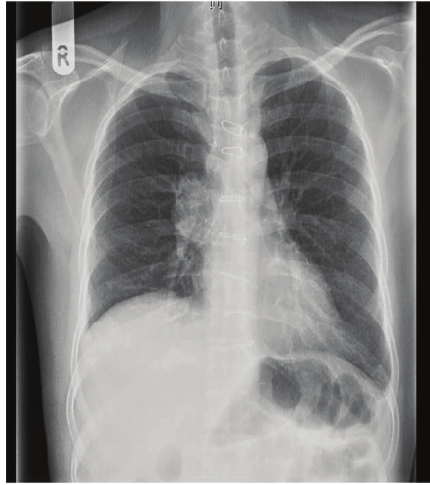
Figure 4: Postoperative chest X-ray showing residual mass in the anterior mediastinum.